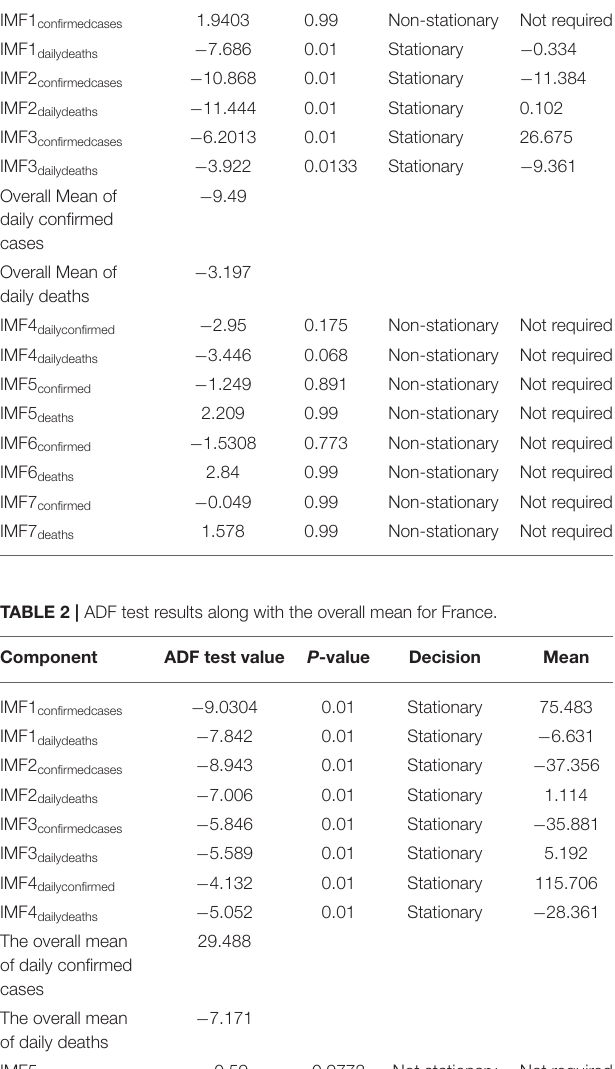
TABLE 1 | ADF test results along with the overall mean for Italy. Component